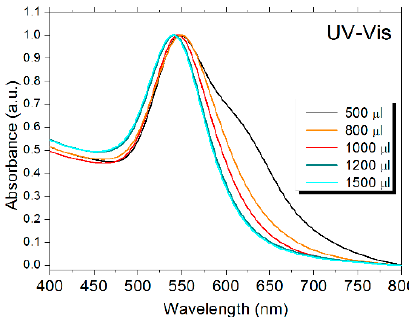
Figure 1. Normalized UV-Vis absorption spectra of the AuNPs obtained by reducing the HAuCl 4 salt with different amounts of 1% aqueous warfarin solution.